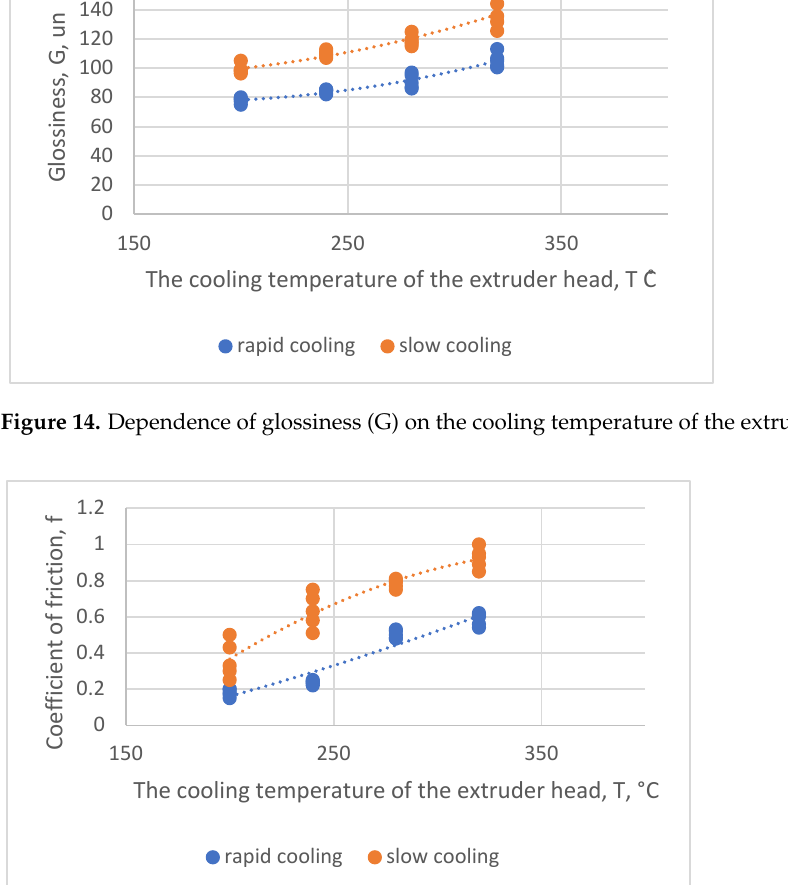
Figure 16. Influence of the crystallization line height value on the glossiness of the film. Figure 17. Influence of the crystallization line height on the milkness. With an increase in T e , macro defects (longitudinal stripes, local thickenings, defects of the “fish eye”, “gel” type, etc.) decrease, and the supramolecular structure, as determined by the temperature and time of crystallization, changes. With increasing T e , as well as an increase in the melt flow rate, the optical properties of the films are improved. Therefore, to obtain both smooth and shiny films, increasing the value of the T e parameter or decreasing the value of the N parameter is recommended. For these purposes, it is better to use a polymer with the minimum permissible molecular weight.